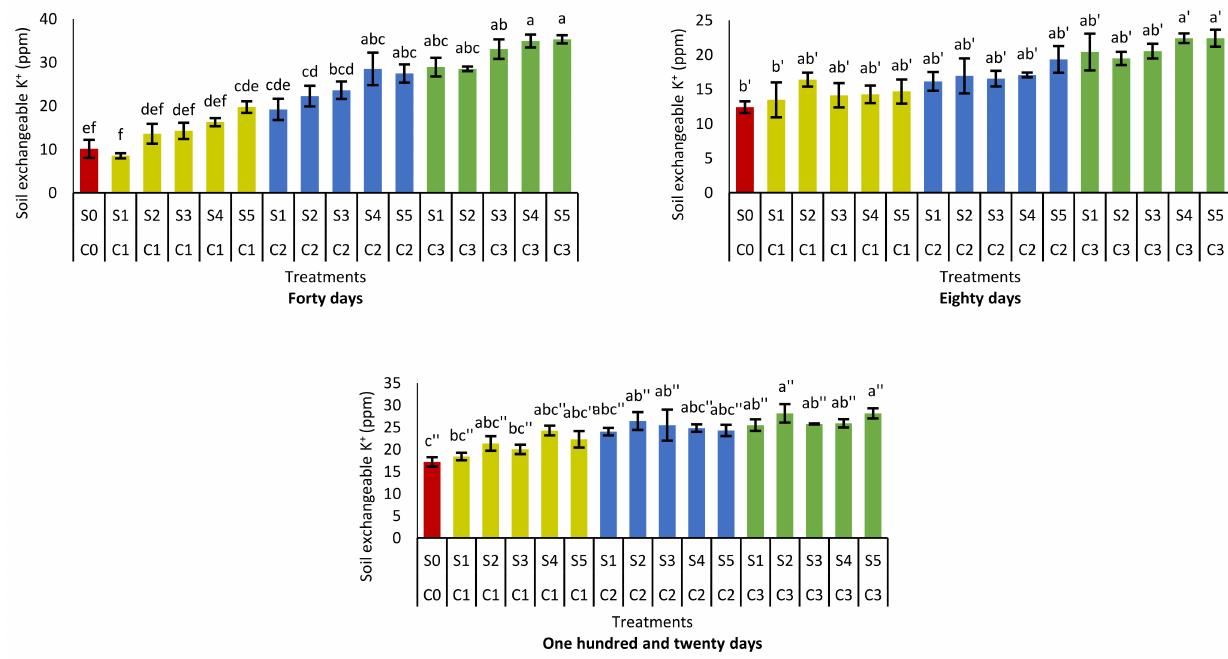
Figure 1. Soil exchangeable potassium in relation to combined use of Calciprill and sodium silicate at forty, eighty, and one hundred and twenty days incubation. Different letters indicate significant mean differences using Tukey’s HSD test at p ≤ 0.05. The error bars refer to ± standard error of three replicates. Small letters, small letters with ’, and small letters with ” indicate mean comparison at forty, eighty, and one hundred and twenty days incubation, respectively.